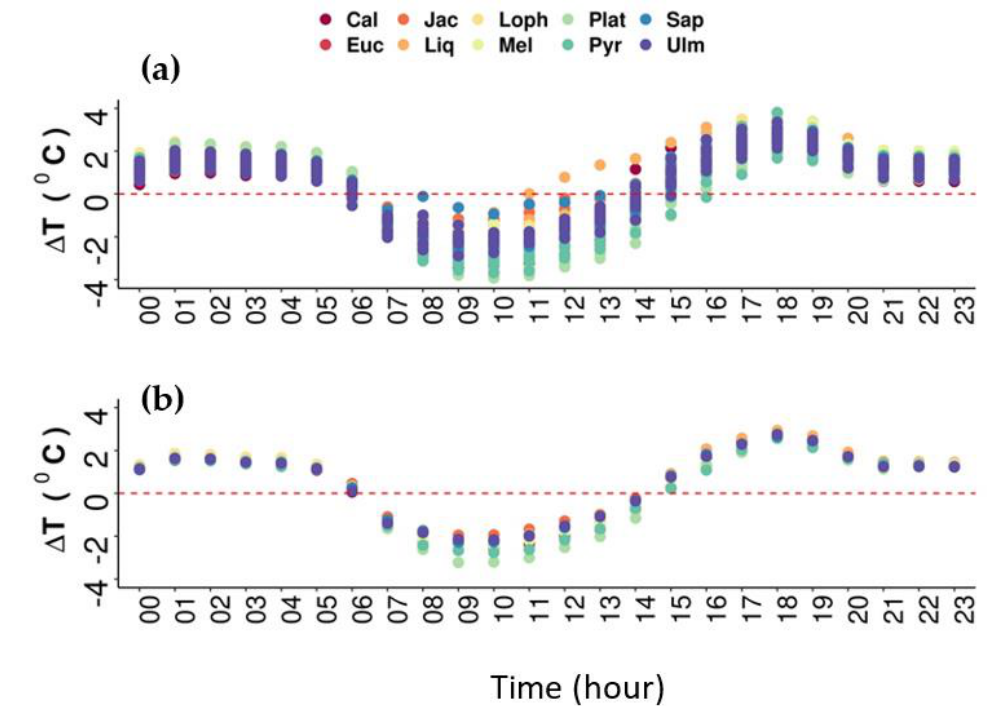
Figure 3. Diurnal variations in Δ T averaged across 37 summer days for individual trees (n = 96) ( a ) and species averages (9 to 10 replicates for each species) ( b ). The dashed red lines indicate no difference between the sub-canopy and ambient air temperatures. Circle colours correspond to tree species. For abbreviations of species names and number of trees for each species see Table 1 .